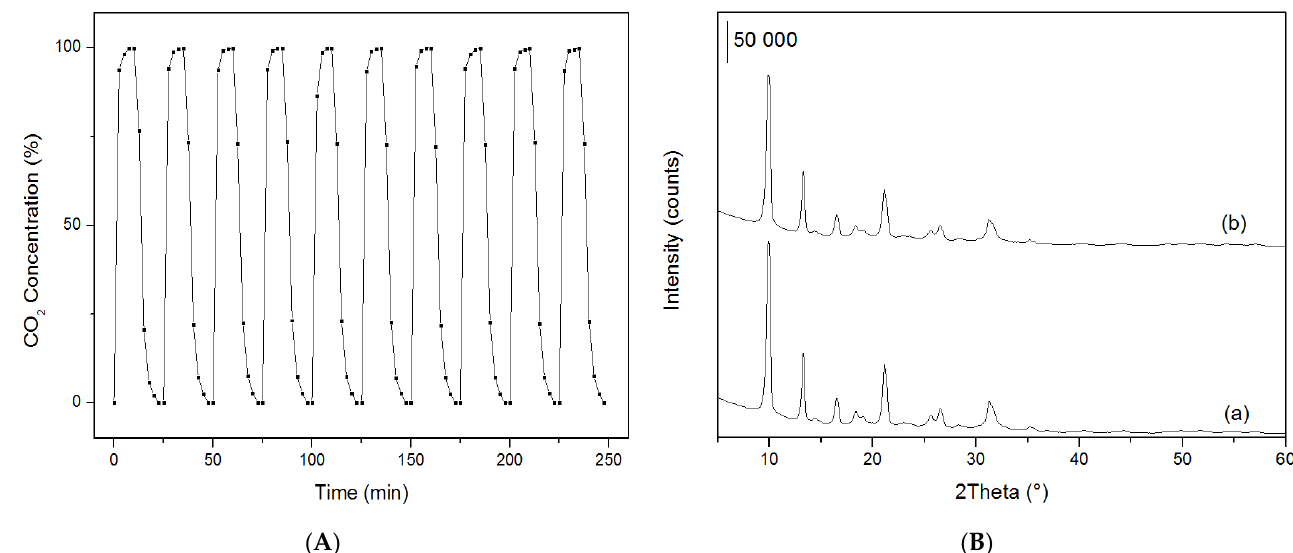
Figure 9. ( A ) CO 2 adsorption/desorption cycling on Na-SSZ-13-meso-0.4 and ( B ) XRD pattern of Na-SSZ-13-meso-0.4-40 ( a ) before and ( b ) after 15 sorption cycles.